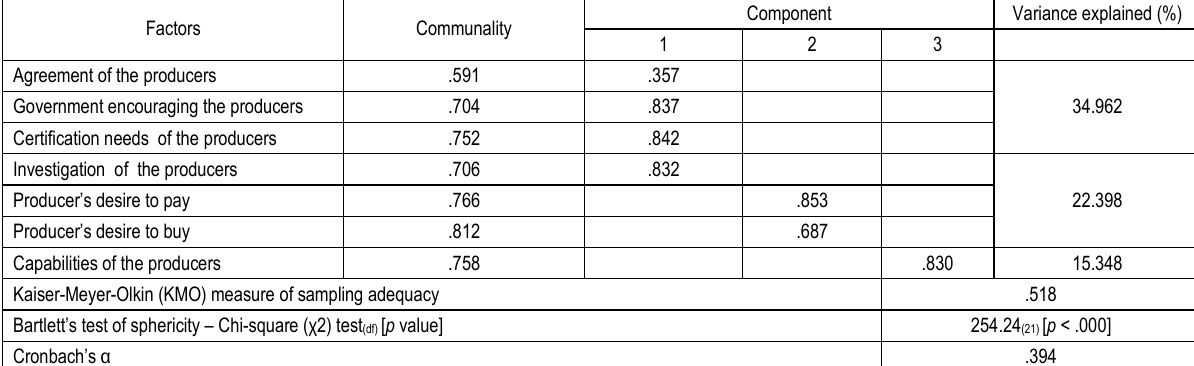
Table 7. Grade of the agreement and disagreement on green economy on the producer side